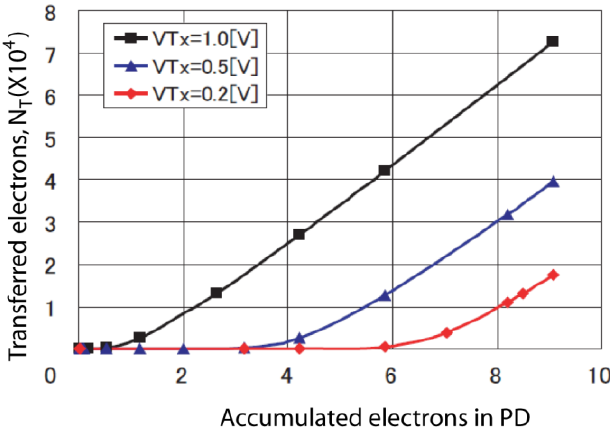
Figure 4. Partially transferred electrons vs accumulated electrons in